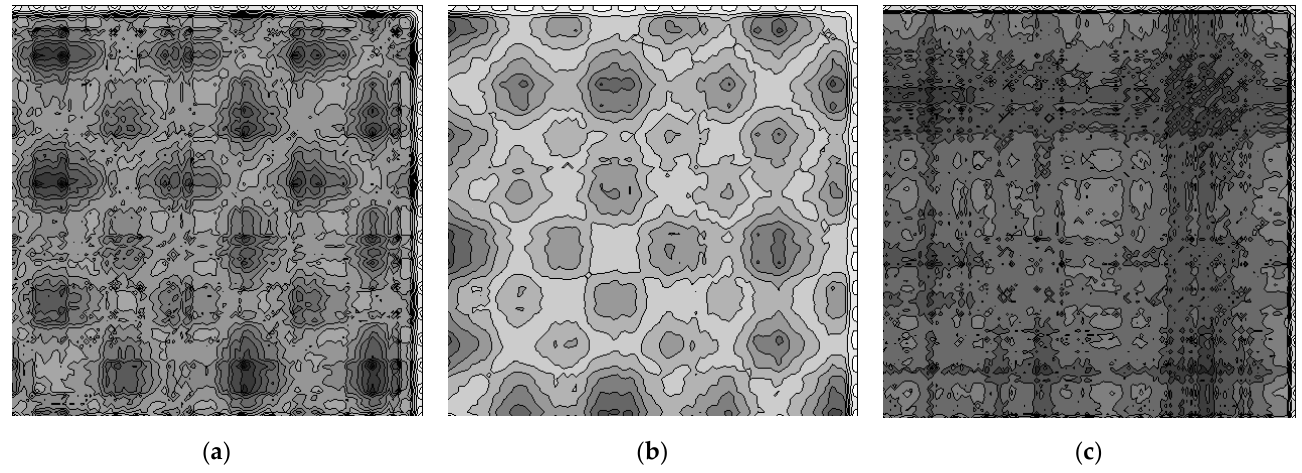
Figure 7. Recurrence plots for sound emissions of insert 3: ( a ) new tool; ( b ) worn tool flank wear of 0.28 mm; ( c ) worn tool flank wear of 0.43 mm.